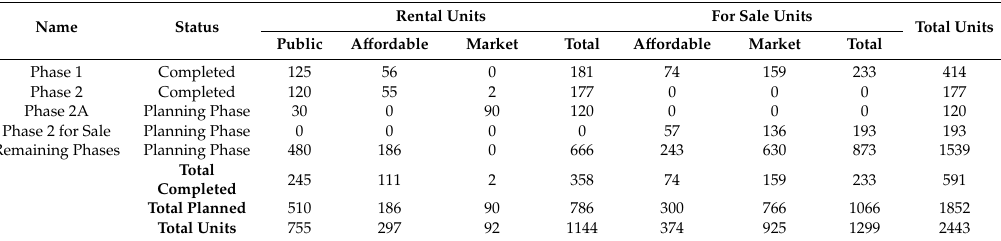
Table 1. Roosevelt Square Unit